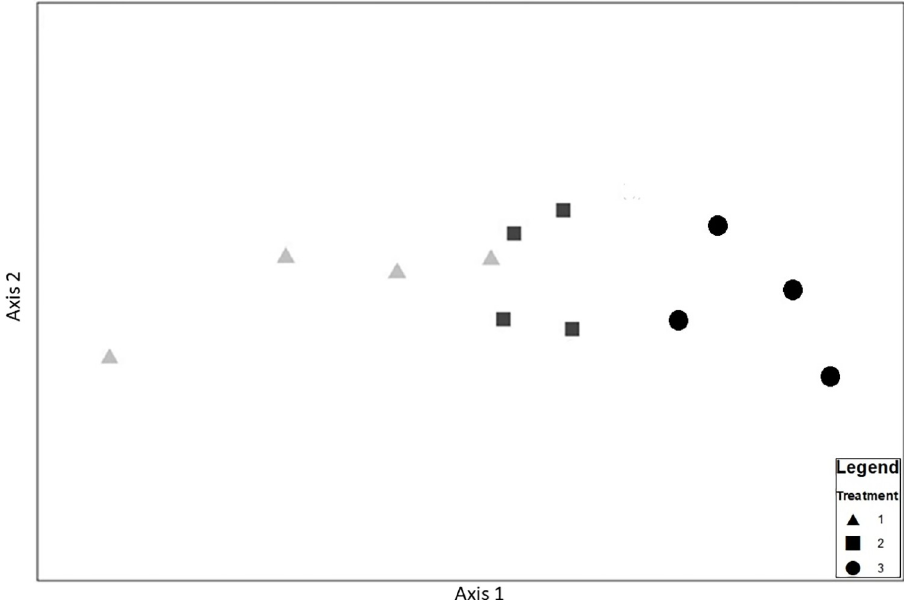
Fig 3. Changes in benthic macrofaunal community with years since disturbance (2D stress =